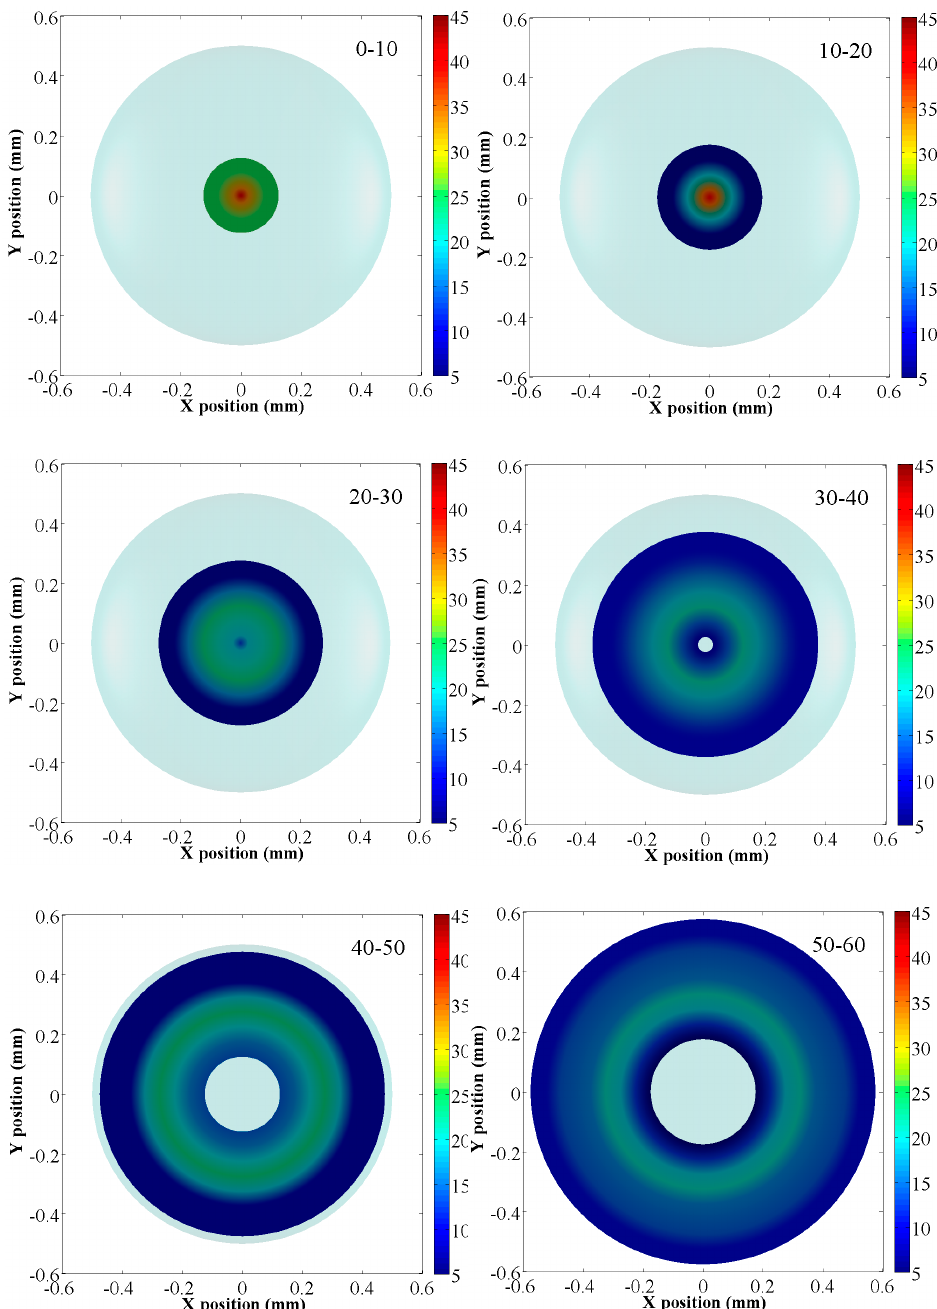
Figure 7. Distribution of initial settlement position of each collision angle.